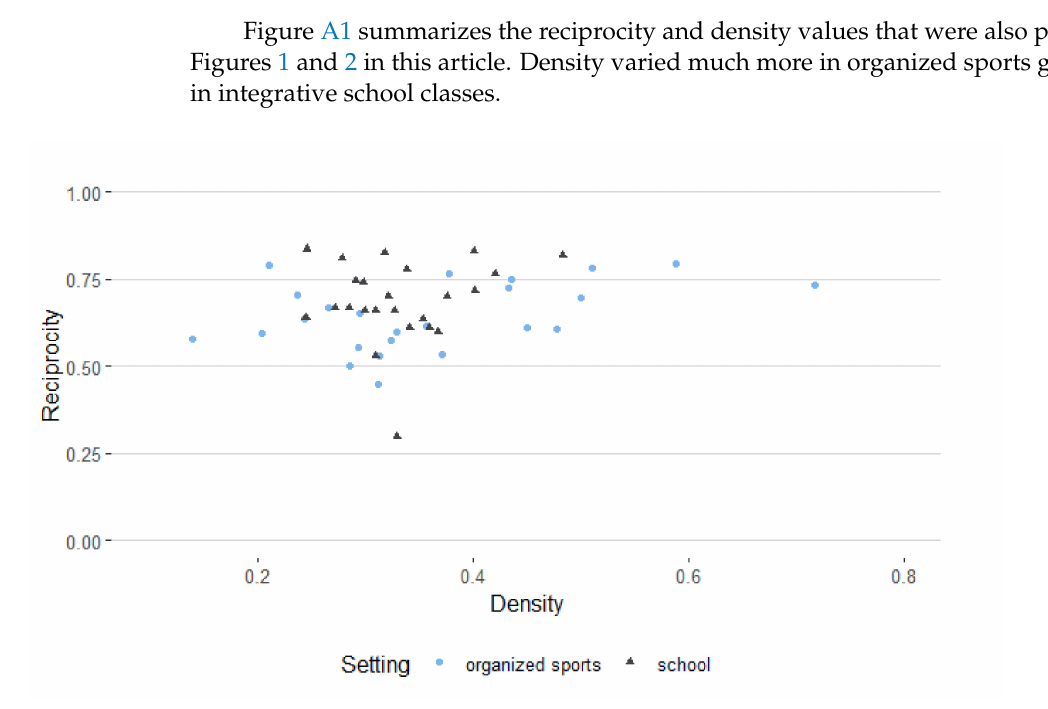
Figure A1. Density and reciprocity in friendship networks of integrative organized sports and at